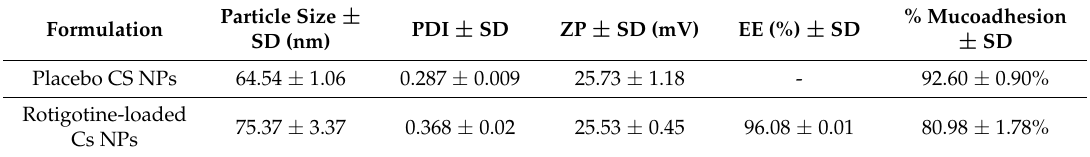
Table 4. The optimized formula for placebo and rotigotine-loaded chitosan